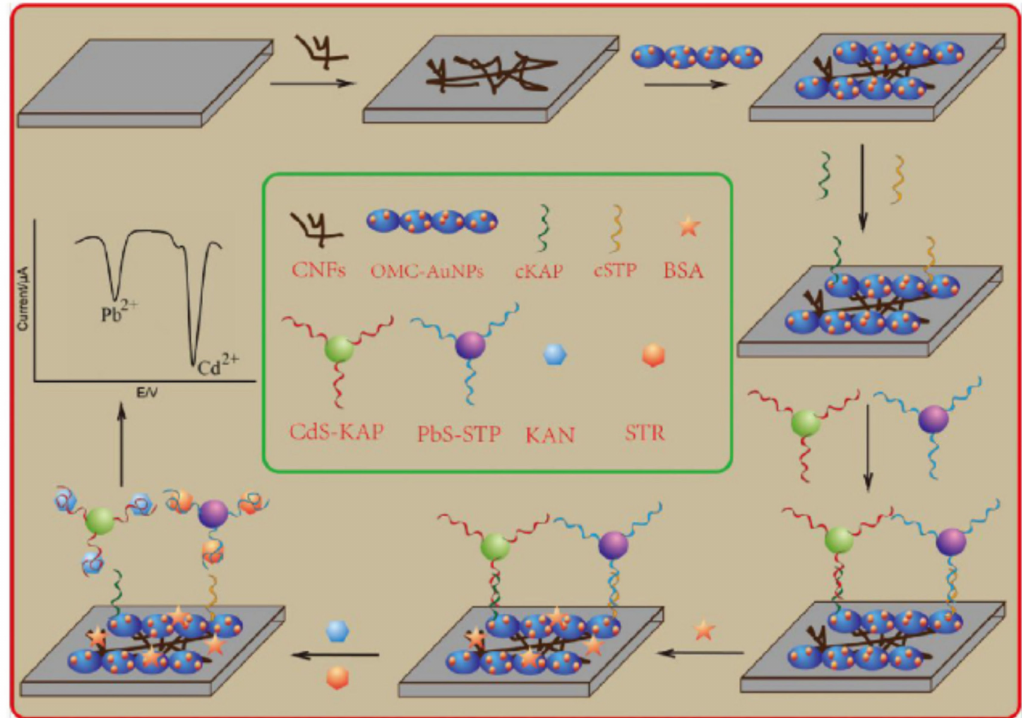
Figure 17. Multiplex electrochemical aptasensor for the multiplex detection of kanamycin and streptomycin in milk based on carbon fiber (CNFs) and mesoporous carbon-gold nanoparticles (OMC-AuNPs). Reprinted from reference [138] with permission from